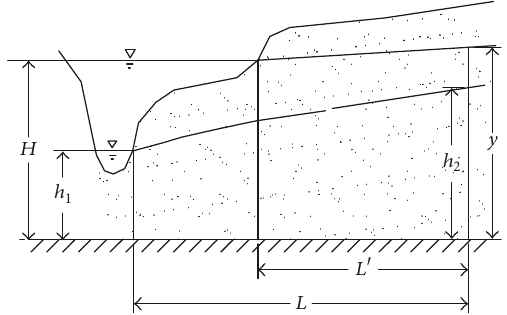
Figure 5: Groundwater level variation before and after reservoir